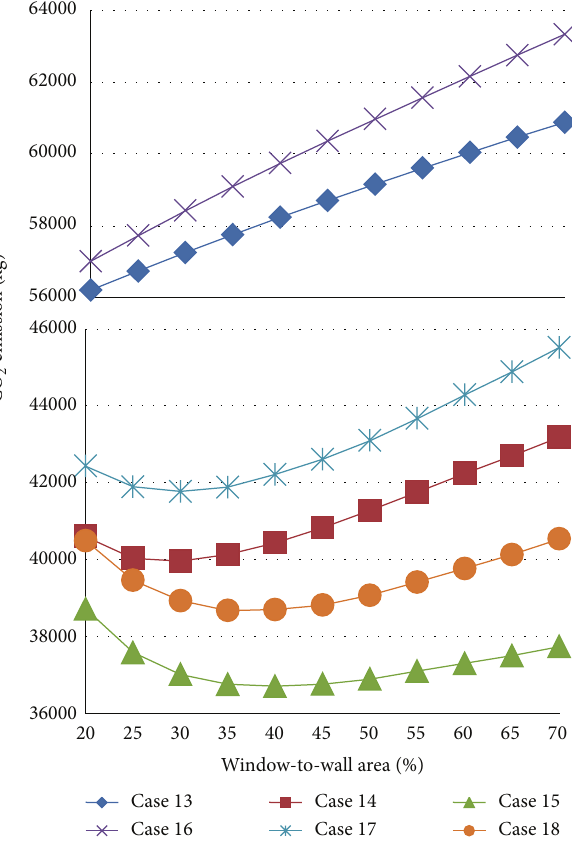
Figure 8: Results for cases